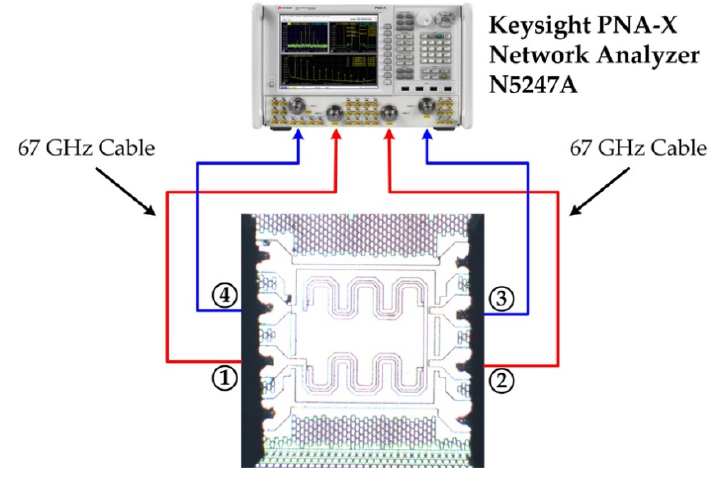
Figure 9. Measurement setup.